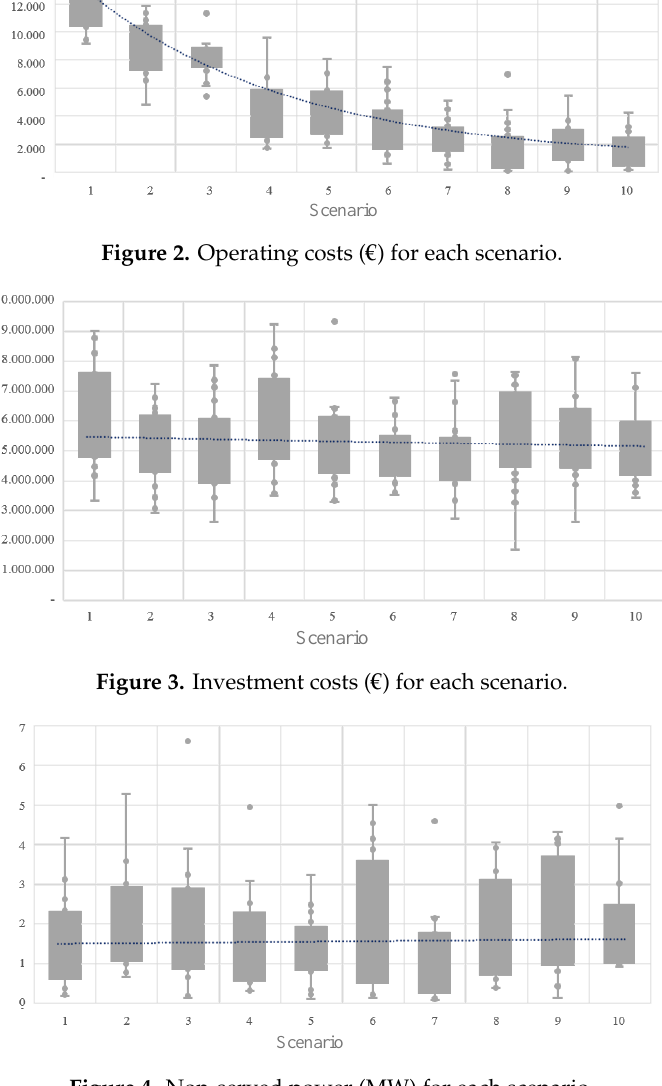
Figure 4. Non-served power (MW) for each scenario.